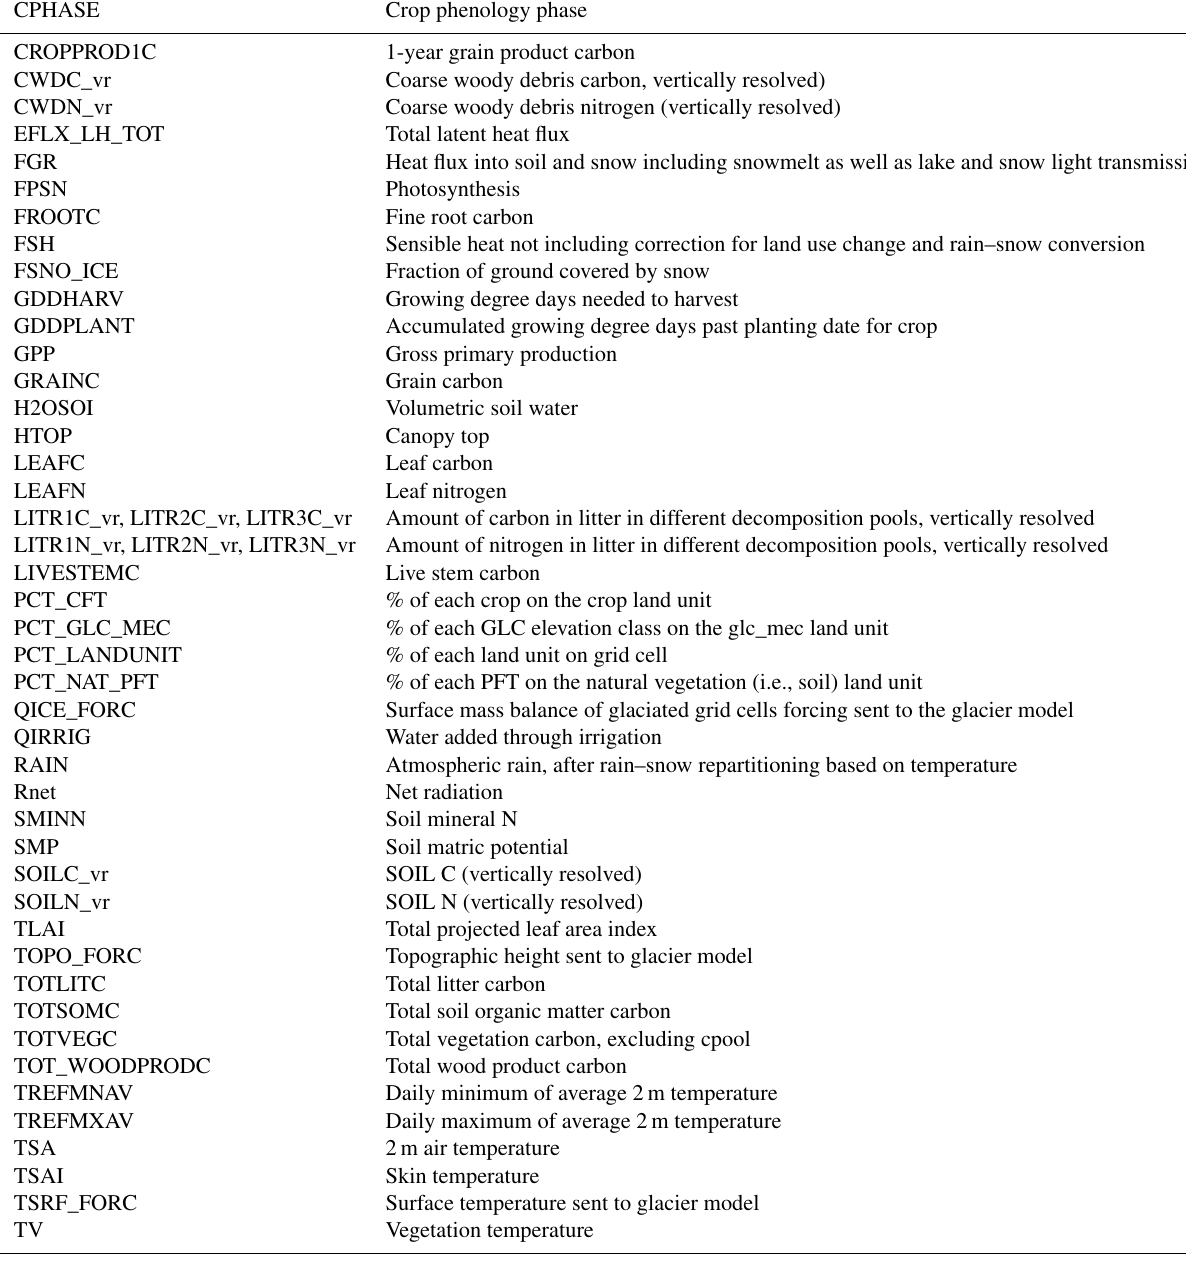
Table A7. Available daily averaged output from the land model at grid cell level in ARISE-SAI-1.5 simulations and five additional SSP2–4.5 CESM2(WACCM6) simulations. None of the above output is contained in the first five ensemble members of CESM2(WACCM6) SSP2–4.5